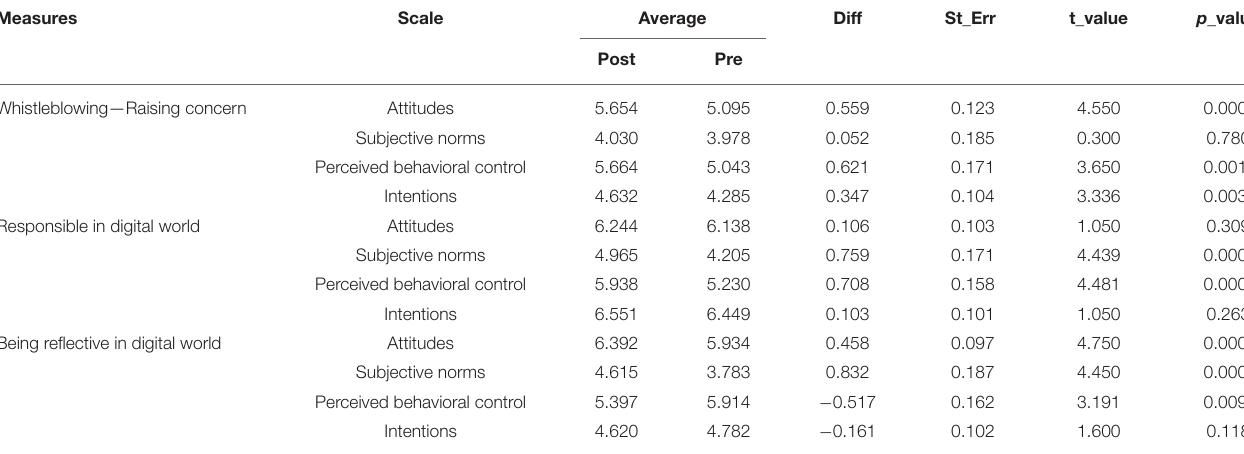
TABLE 4 | A univariate analysis of MEeP domain scores following an online social media professionalism intervention ( n = 59).